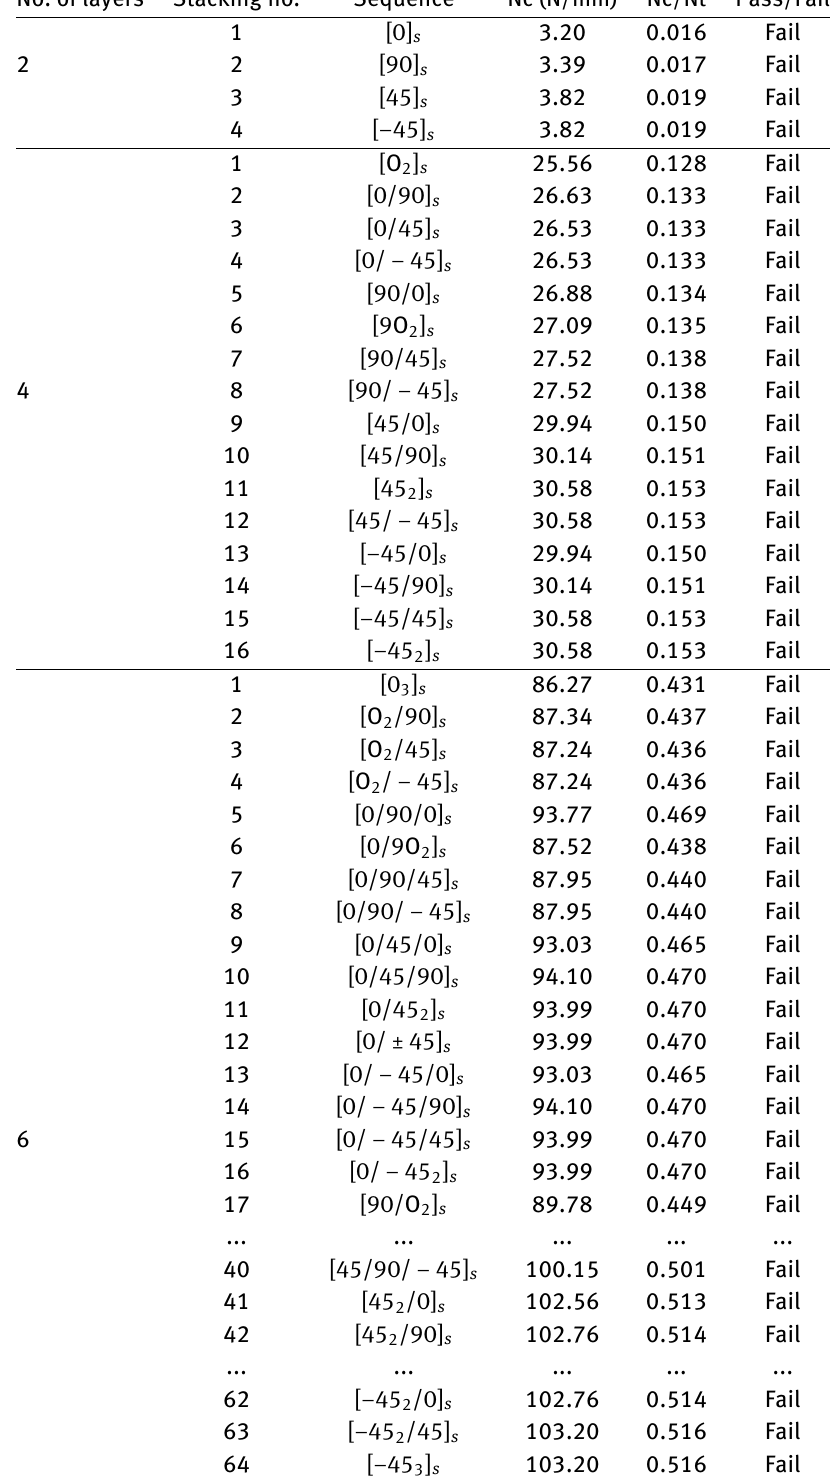
Table 3: Analytical critical buckling load for all possible stacking sequences of 2, 4 and 6 layers of symmetric UD laminates when the set target buckling load is